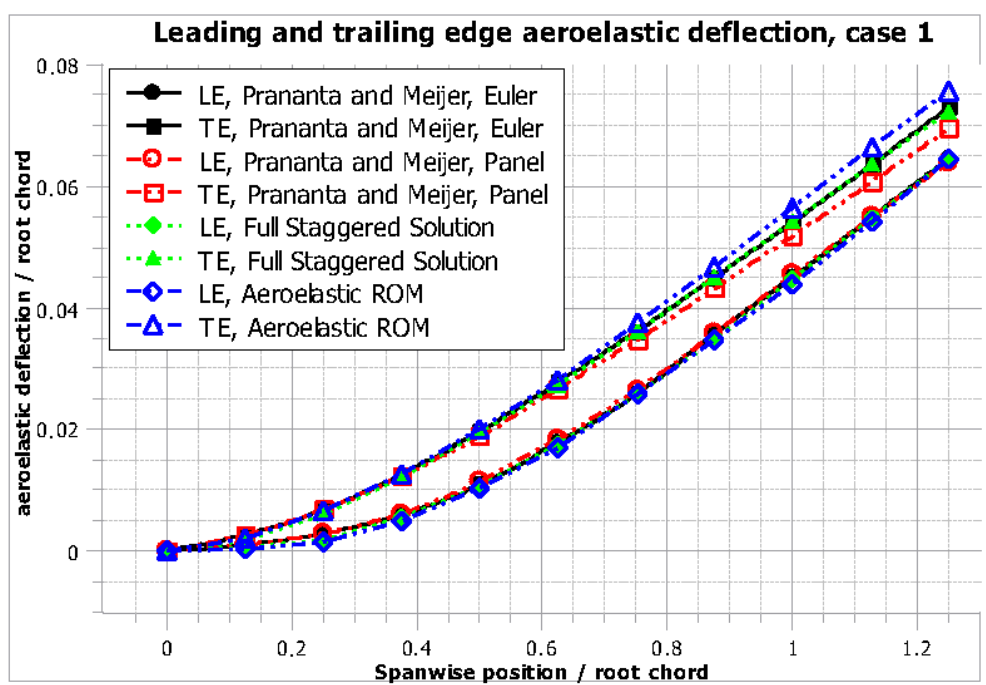
Figure 11. AGARD wing Case 1: normalized static aeroelastic displacement plot, leading (LE) and trailing (TE) edge.